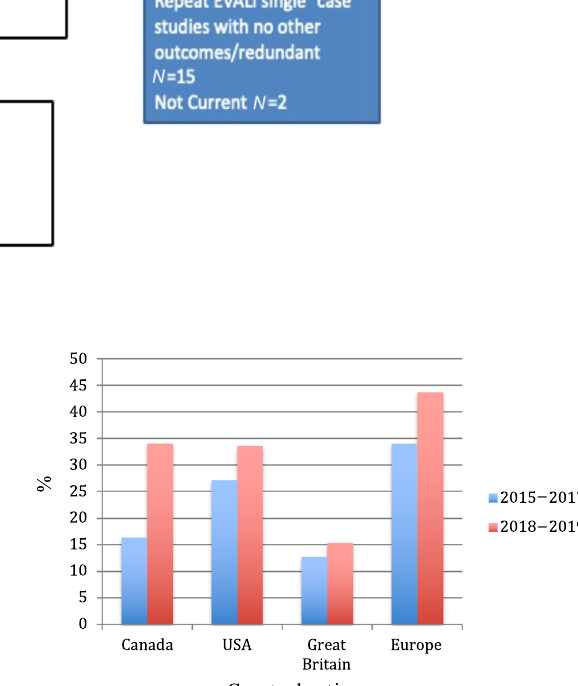
Fig. 2 History of “ Ever Use ” of e-cigarettes in teenagers by country and period 9,18,25 – 27,30,33 . History of “ ever use ” of e-cigarettes in Canada, the United States, Great Britain, and the rest of Europe between 2015 – 2017 and 2018 – 2019 9,18,25 – 27,30,33 . If countries reported history of past use within any of these time periods, they were included. Please note that the 2015 – 2017 prevalence of ever use is for the following European countries: Belgium, Finland, Germany, Ireland, Italy, the Netherlands, and Portugal 28 . The 2018 – 2019 report in Europe collected data from Central and Eastern Europe, including the following countries: Poland, Lithuania, Belarus, Slovakia, and Russia 18 . It should be noted that while the report by Hammond et al 9 reported a prevalence of “ ever use ” in the United Kingdom of 32.7% (2018), the Action and Smoking on Health Report in England 25 produced a signi fi cantly lower prevalence of 16.4% for the same period in Great Britain. It could be that Northern Ireland has a higher prevalence of ever use and was omitted from the